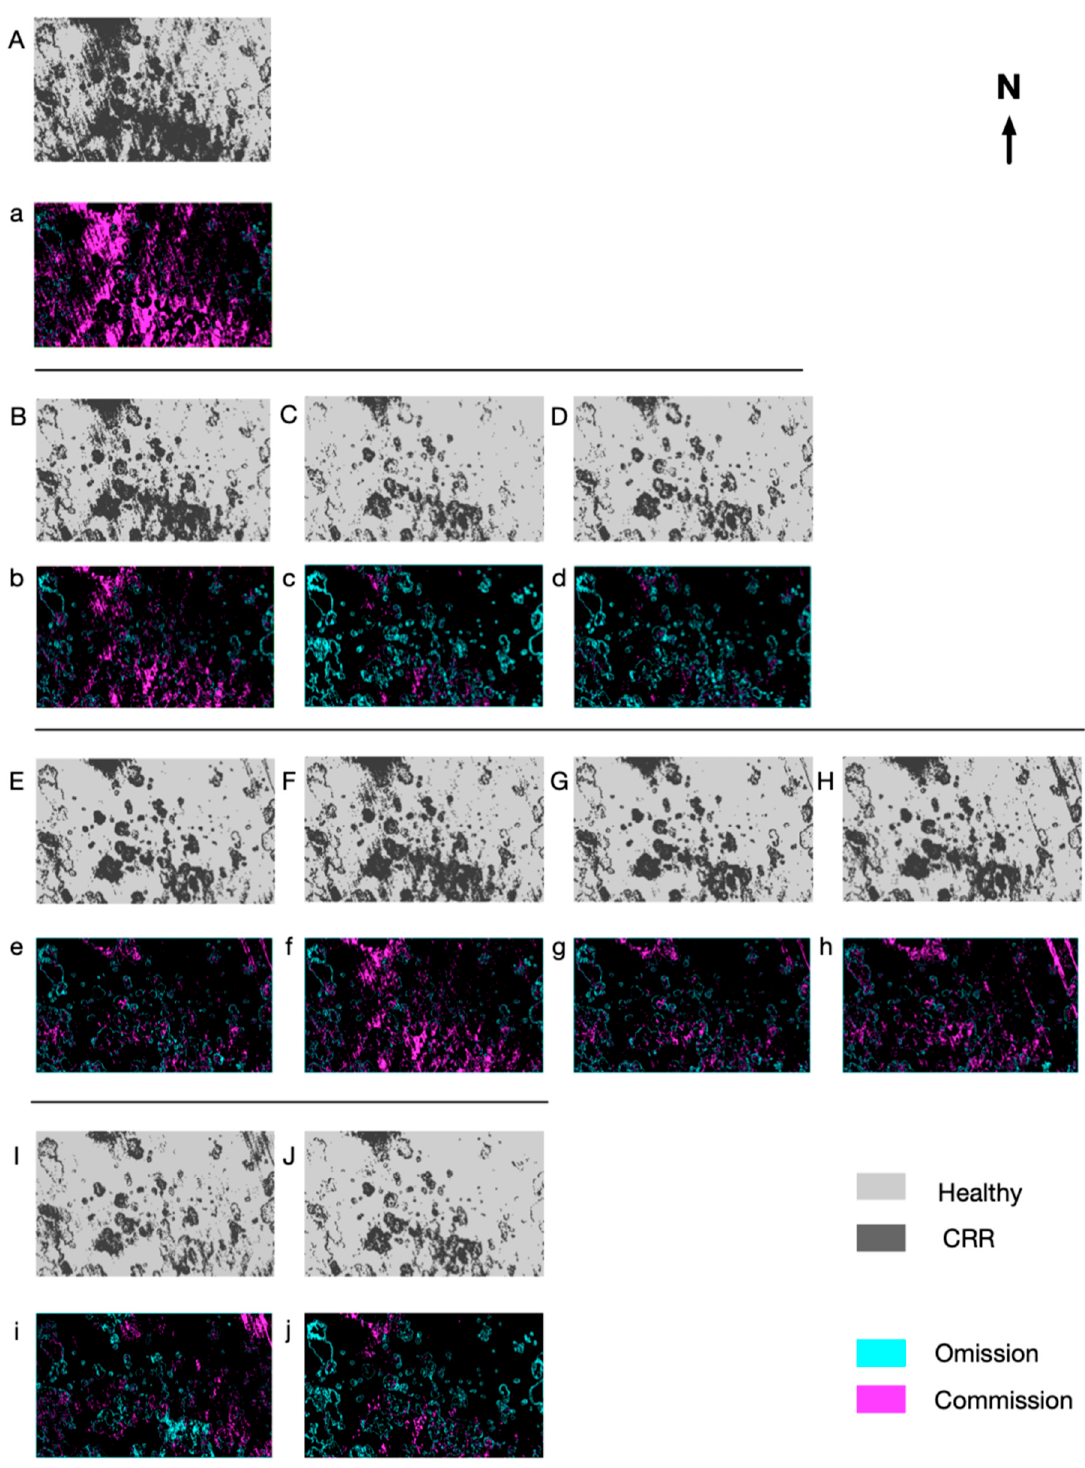
Figure 12. Classification results of ( A ) 2-class k-means, ( B ) combined 3-class k-means, ( C ) combined 5-class K-means, ( D ) combined 10-class k-means, ( E ) SVM, ( F ) minimum distance, ( G ) maximum likelihood, ( H ) Mahalanobis distance, ( I ) KMSVM, and ( J ) KMSEG. Corresponding error maps of: ( a ) 2-class k-means, ( b ) combined 3-class k-means, ( c ) combined 5-class k-means, ( d ) combined 10-class k-means, ( e ) SVM, ( f ) minimum distance, ( g ) maximum likelihood, ( h ) Mahalanobis distance, ( i ) KMSVM, and ( j ) KMSEG. (Scale 1:9000).